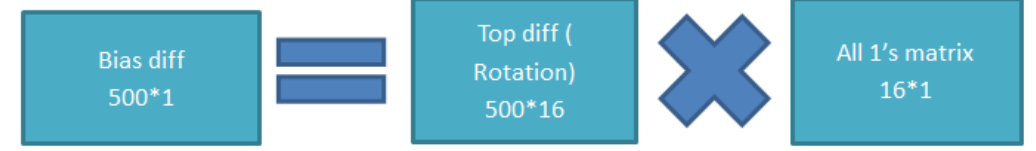
Figure 13 Find the derivative of the bias coefficient